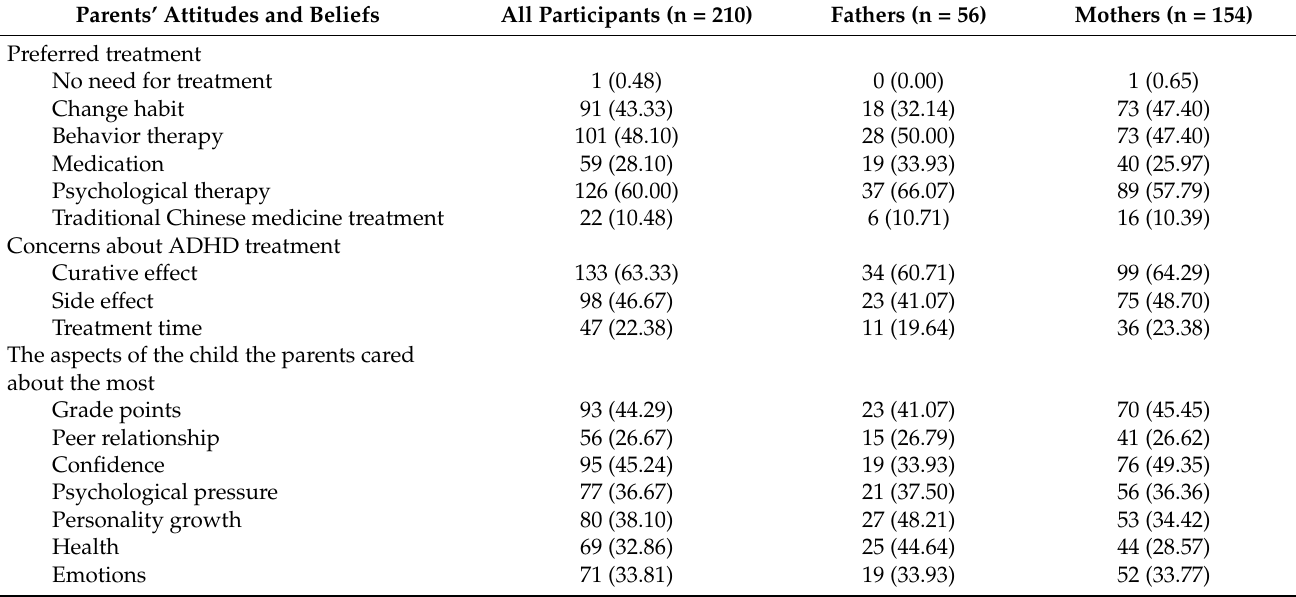
Table 3. Parents’ views on ADHD treatment and their concerns (N